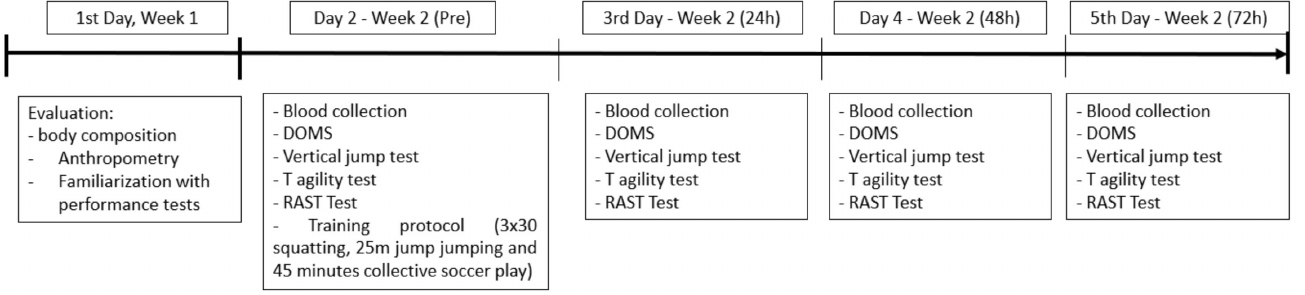
Figure 1. Experimental